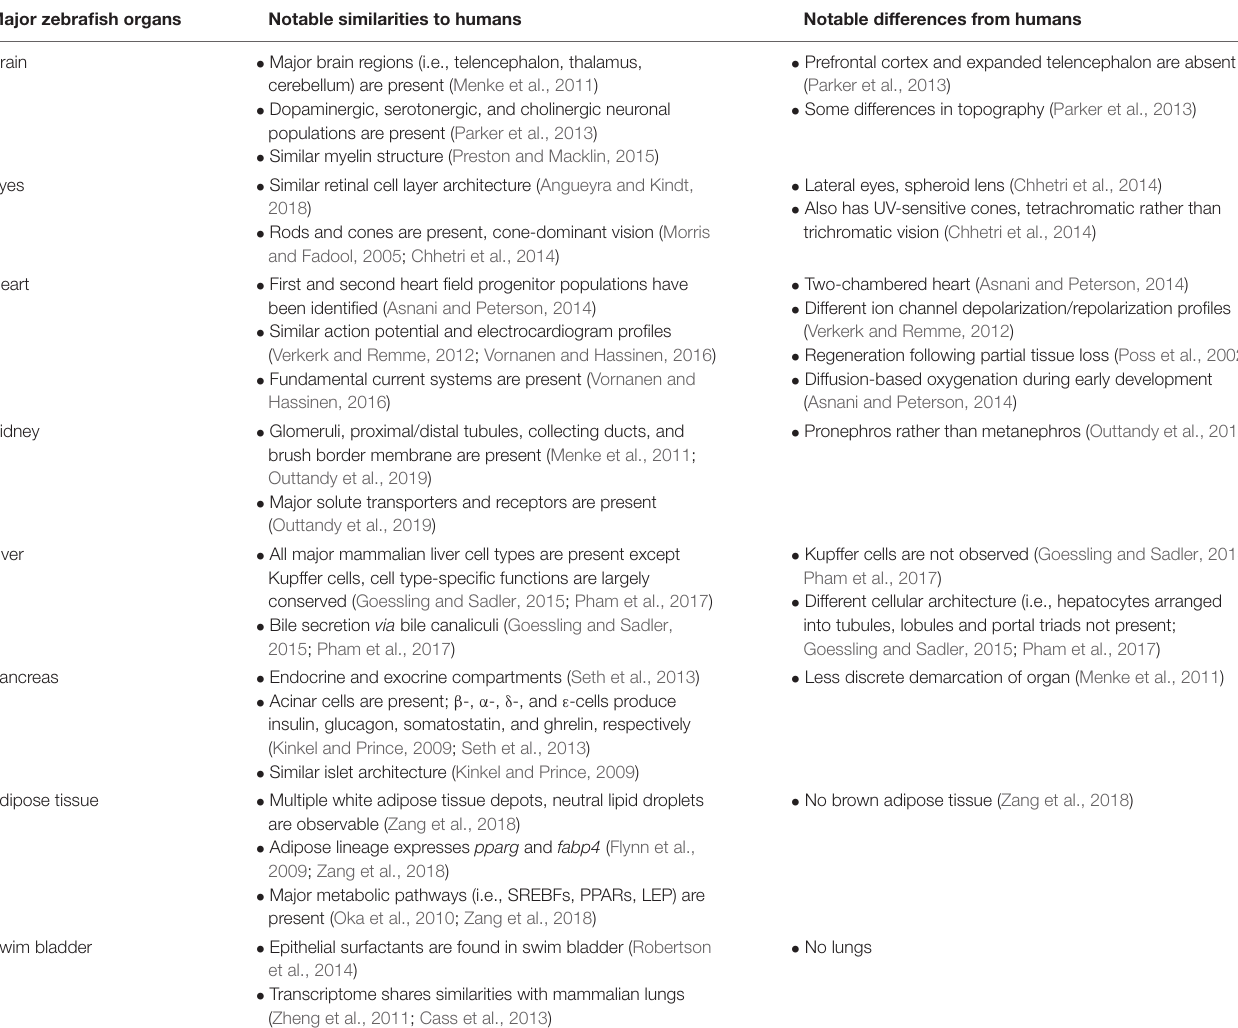
TABLE 1 | Notable similarities and differences between major zebrafish organs and human counterparts. Major zebrafish